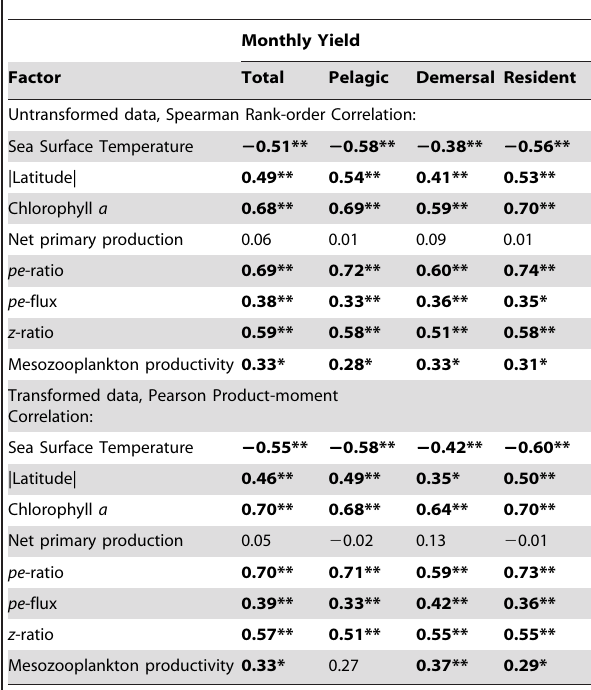
Table 2. Spearman rank-order and Pearson product-moment correlation between fisheries yields and factors for untransformed and transformed data,